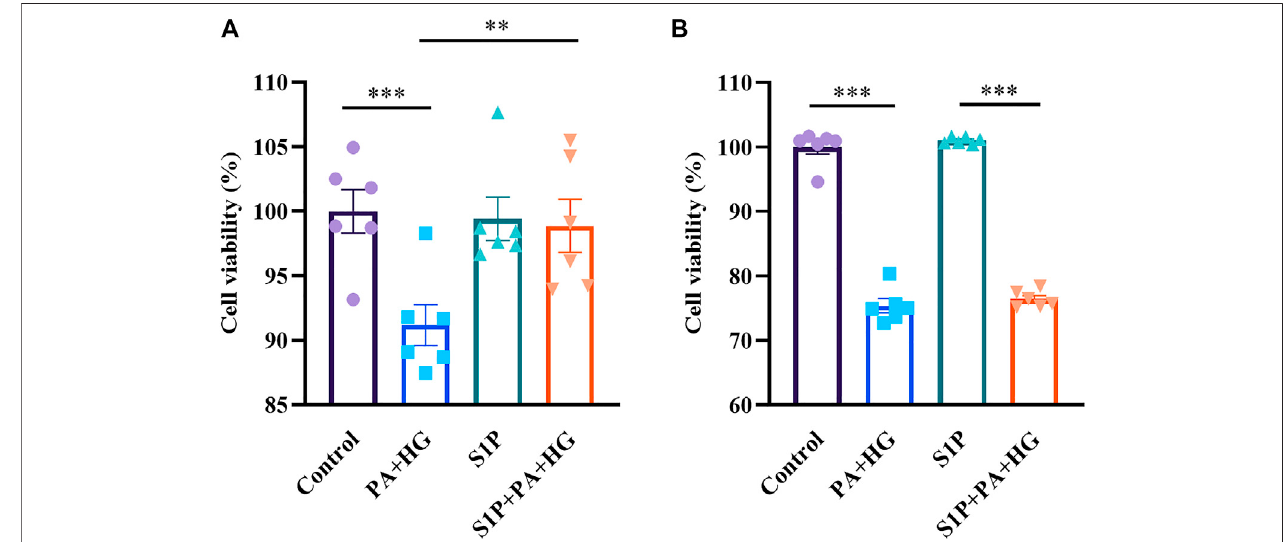
FIGURE 8 | Effects of sphingosine 1-phosphate (S1P) on the cell viability of INS-1 cells and Chinese hamster ovary (CHO)-Kv2.1 cells. INS-1 cells or CHO-Kv2.1 cells were incubated with different treatments for 24 h, and viability was measured via the CCK8 assay. (A) S1P (10 μ M) improved the viability of INS-1 cells treated with palmitic acid and high-concentration glucose (PA+HG, n (cid:2) 6; **p < 0.01, ***p < 0.001; by one-way ANOVA). (B) S1P (10 μ M) had no effect on the viability of CHO-Kv2.1 cellstreatedwithpalmiticacidandhigh-concentrationglucose(PA+HG, n (cid:2) 6;*** p < 0.001;byone-wayANOVA).Thecellviabilityofeachgroupwasnormalizedby that of the control group. The results represent by the mean ± SEM.